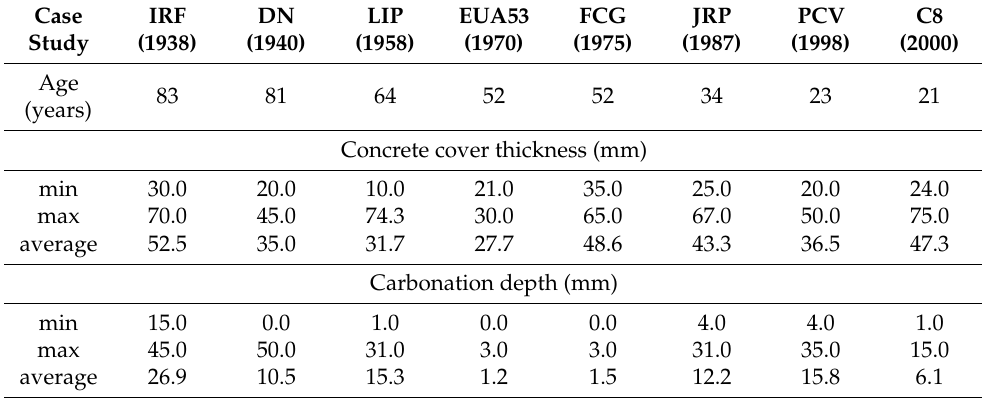
Table 10. Summary of the main characteristics of the NAC in sampling zones.